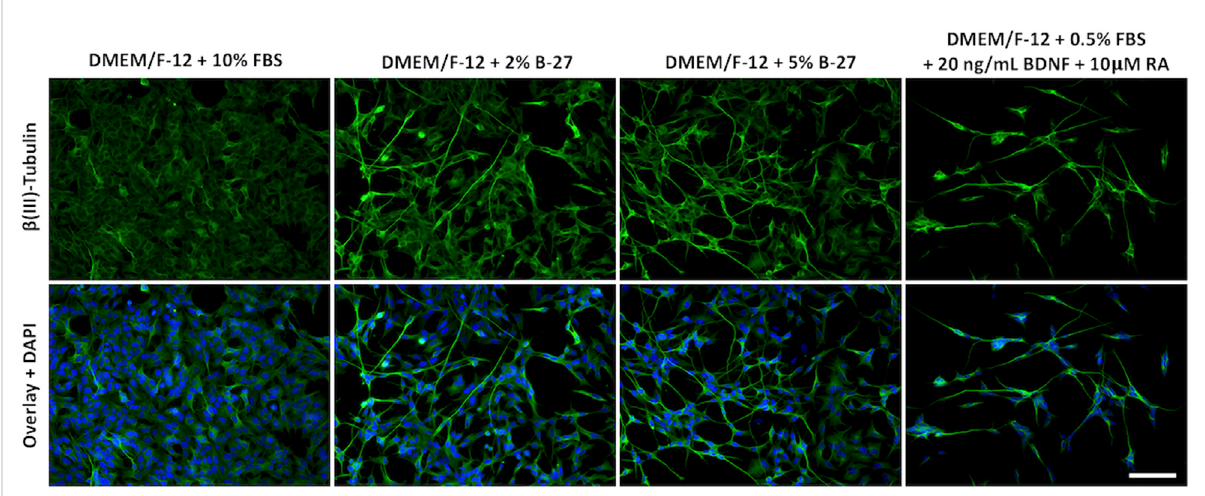
FIGURE 5 B-27encouragesneuriteoutgrowthanddifferentiationinSH-SY5Ycells. SH-SY5YcellswereculturedinDMEM/F-12supplementedwitheither 10% FBS, 2% B-27 supplement, 5% B-27 supplement or 0.5% FBS + 20 ng/ml BDNF + 10 μ M RA for 5 days. Cells were fi xed with 4% PFA for 20 min. Microtubules were stained with 1:500 mouse anti- β (III)-Tubulin ( R&D Systems , #MAB1195) and visualized with 1:400 Alexa Fluor ® 488-conjugated donkey anti-mouse ( Thermo Scienti fi c , #A21202) (green). Nuclei were counterstained with 1:5,000 DAPI (blue). Images taken at ×20 magni fi cation through the DAPI channel (excitation 325 – 375 nm; emission 435 – 485 nm) and the FITC channel (excitation 460 – 500 nm; emission 512 – 542 nm) on the Leica DM4000 LED upright fl uorescent microscope. Scale bar = 100 μ m. BDNF, brain-derived neurotrophic factor; DAPI,4 ′ ,6-Diamidino-2-phenylindole;DMEM/F-12,Dulbecco ’ smodi fi